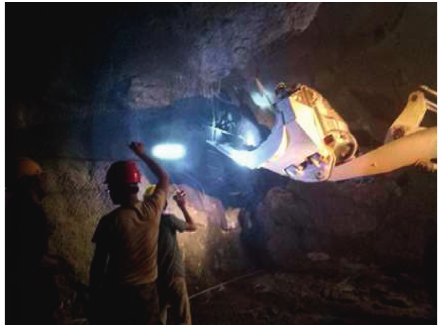
Figure 22: The charging process of